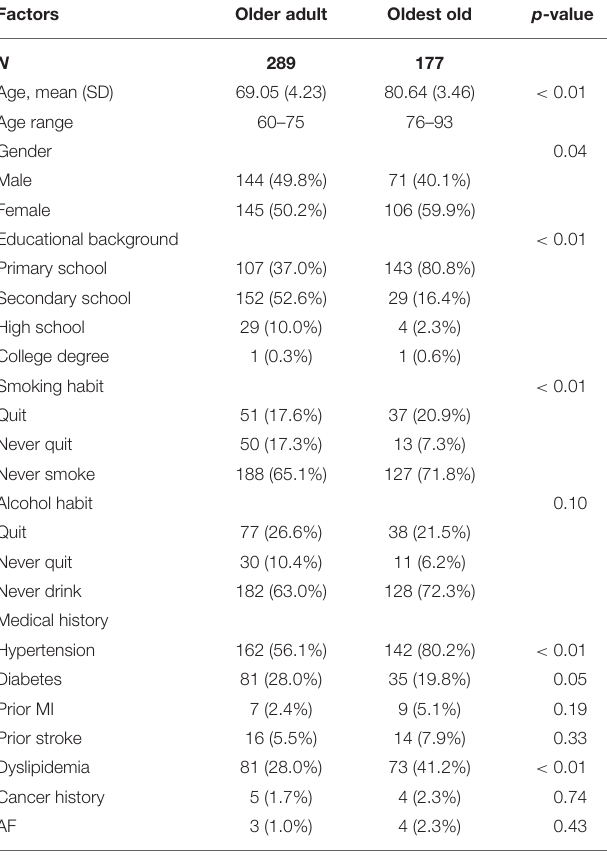
TABLE 2 | Baseline characteristics of the community older adults (age cut-off 75 years).